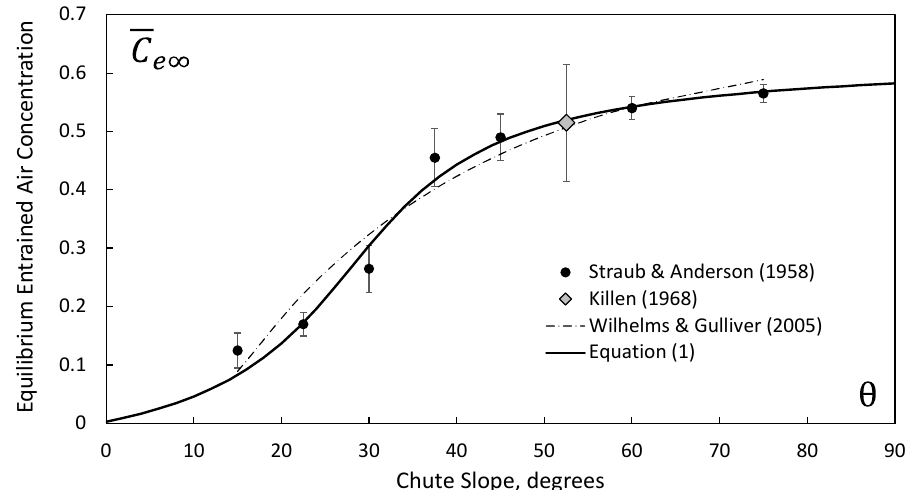
Figure 2. Entrained air concentration in the fully developed aerated flow zone, showing experimental data [9,31], the original curve of Wilhelms and Gulliver [14] and the curve described by Equation (1) that produces more realistic values for low slopes. Error bars are uncertainties in the original experimental values of entrained air as reported by [14].